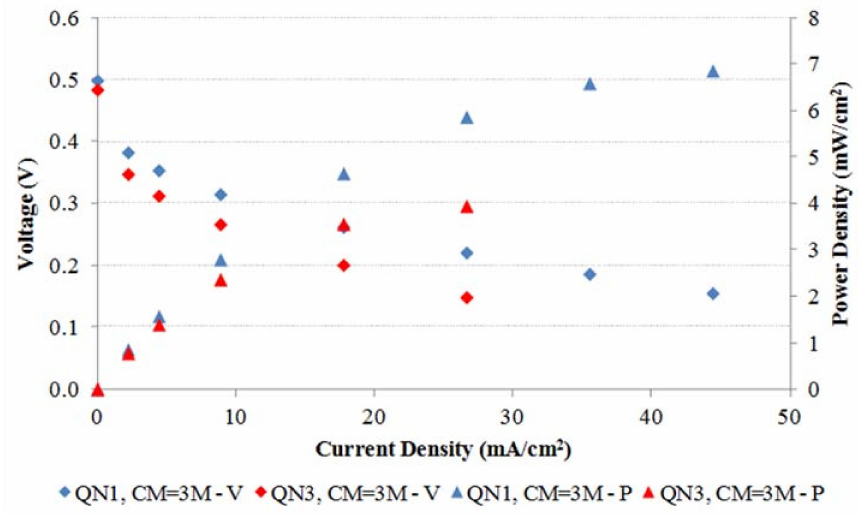
Figure 4. Voltage (V) and power (P) polarization curves comparison for MEAs QN1 and QN3 for the best methanol concentration (CM). Operating conditions: temperature, 25 ◦ C; pressure, 1 atm; methanol/air flow rates, 0.11/130